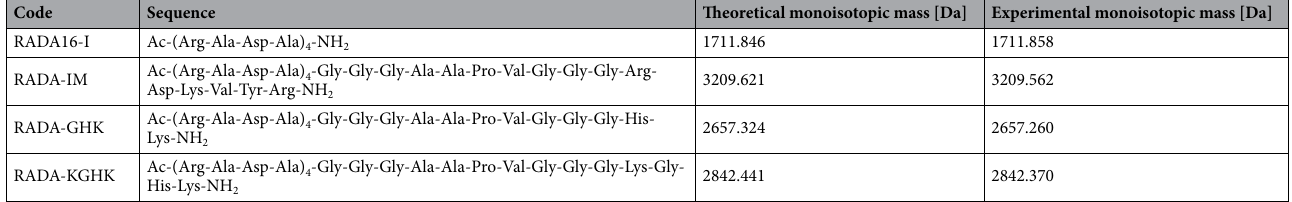
Table 1. Peptide coding, their sequence, and theoretical and experimental